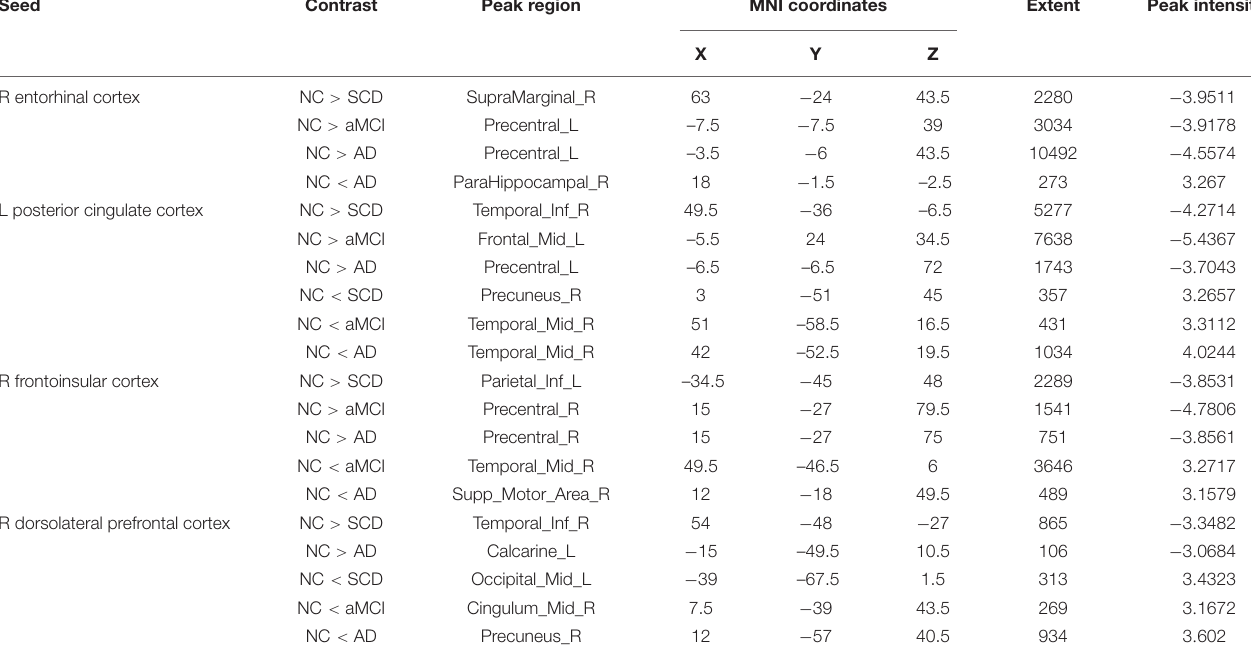
TABLE 2 | Significant between-group (NC-SCD, NC-aMCI, and NC-AD) differences in structural covariance seeding from the DMN, SN, and ECN. Seed